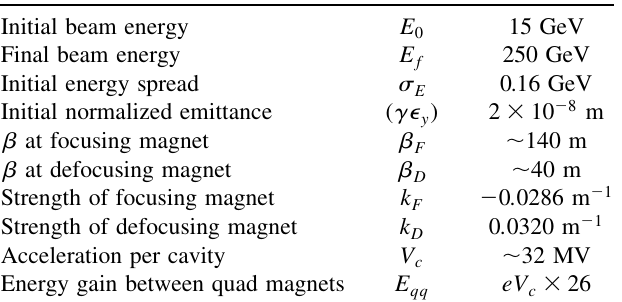
TABLE II. Relevant parameters of the ILC main linac. Initial beam